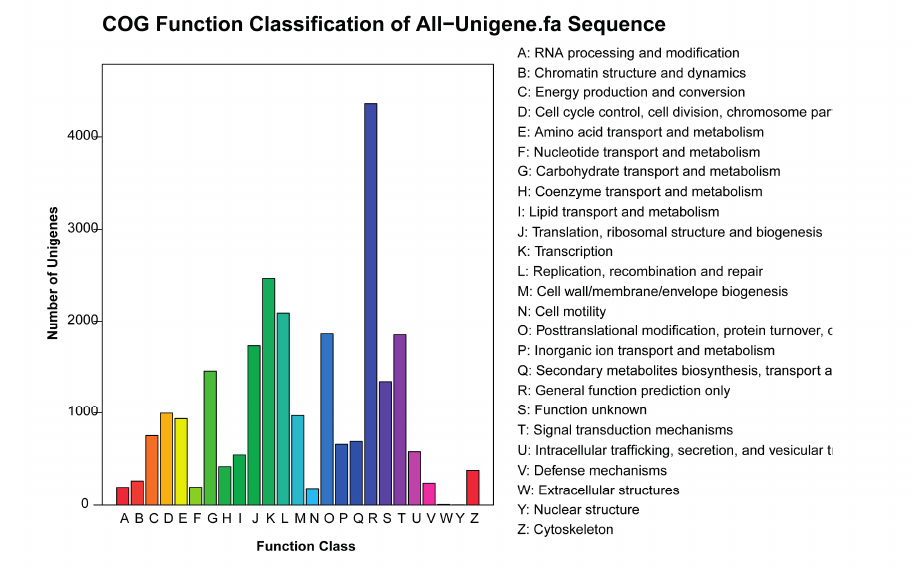
Figure 3. Clusters of Orthologous Groups (COG) function classification of all-unigene sequence. A total of 25,166 unigenes were classified into 25 COG